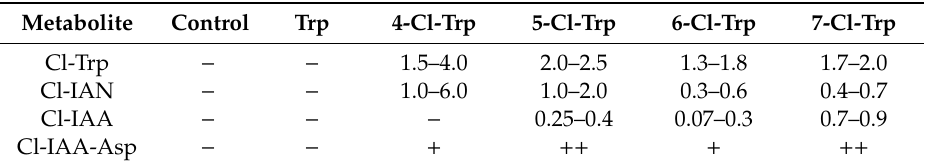
Table 1. Production of different chlorinated indole compounds after feeding chlorinated Trp to wild type A. thaliana plants. Plants were grown for 21 days in liquid medium and 100 µM of Trp derivatives was added. IAN = indole-3-acetonitrile, IAA = indole-3-acetic acid, IAA-Asp = IAA conjugate with aspartate, Trp = tryptophan. Concentration ranges are given as µg g dry weight -1 . For Cl-IAA-Asp the peak could be detected but was below the quantification level (+ present; ++ higher levels present). 4-Cl-IAA could not be detected in the sample (-).